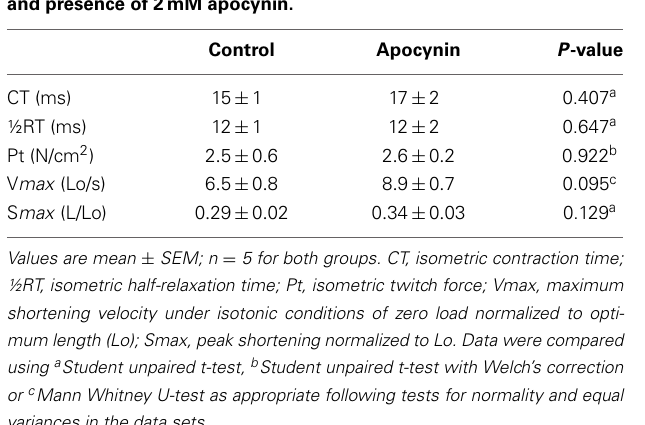
FIGURE 4 | Sternohyoid muscle isometric and isotonic contractile properties in the absence and presence of apocynin. (A) Sternohyoid peak tetanic force (F max ) determined ex vivo in the absence or presence of 2mM apocynin (putative NOX inhibitor). F max was significantly increased in apocynin-treated muscle preparations ( ∗ P = 0.03; Student unpaired t -test). (B) Power-load relationship of sternohyoid muscle determined ex vivo in the absence or presence of 2mM apocynin. Power (force x velocity of shortening) was significantly increased in apocynin-treated preparations ( P = 0.023 (drug); Two Way repeated measures ANOVA; ∗ P < 0 . 01 Bonferroni post-hoc test). Values are mean ± SEM; n = 5 per group.